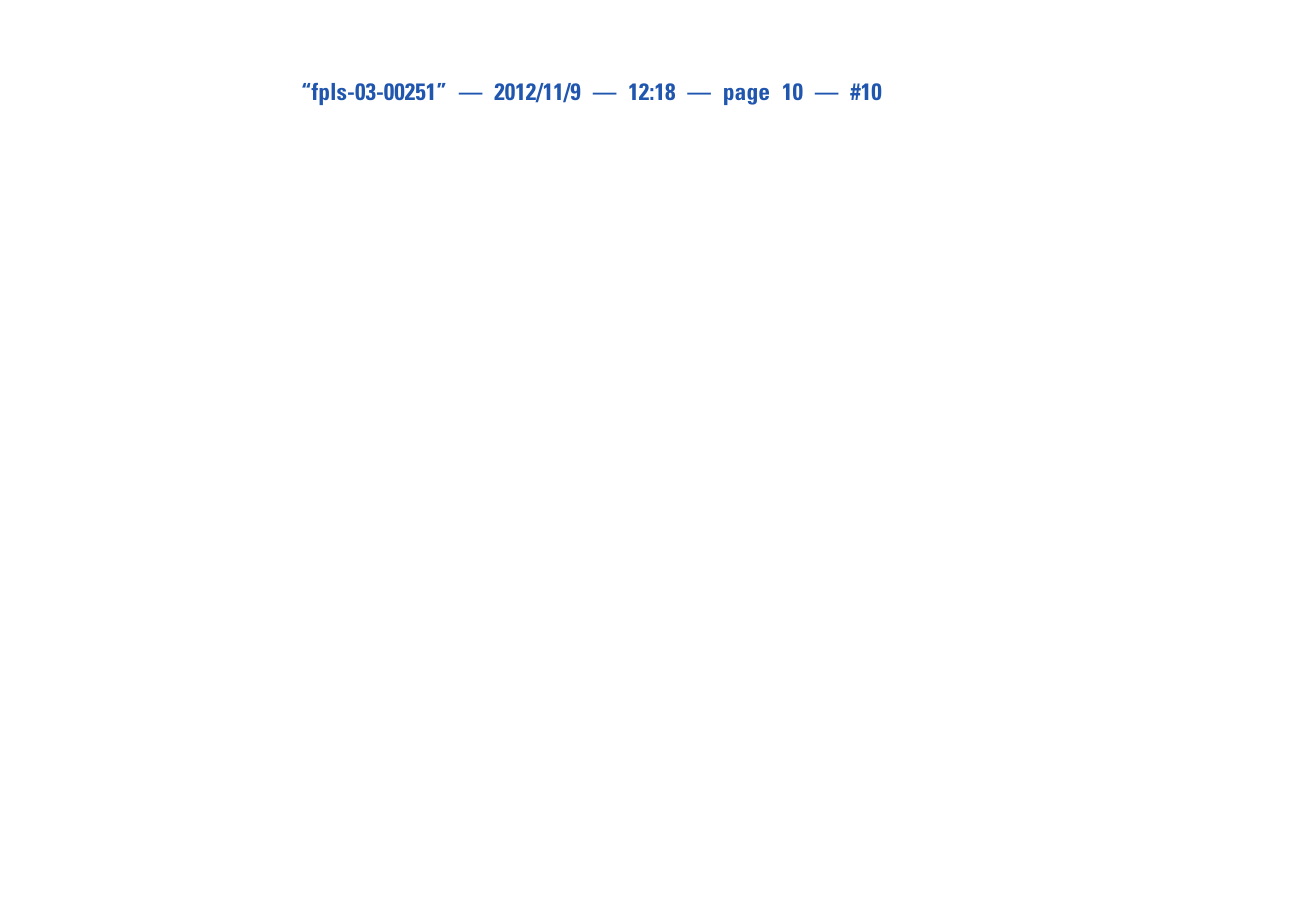
SDS-PAGE and western blot using anti-GFP antiserum to detect KCO3::GFP (A,E) , anti-KCO3 antiserum to detect KCO3::GFP (B,F) or KCO3 (C,G) , anti- γ TIP (D,H) .Top of each gradient is at left. Numbers on top indicate the position along the gradient and the molecular mass (in kDa) of sedimentation markers. Numbers at left indicate the positions of SDS-PAGE molecular mass